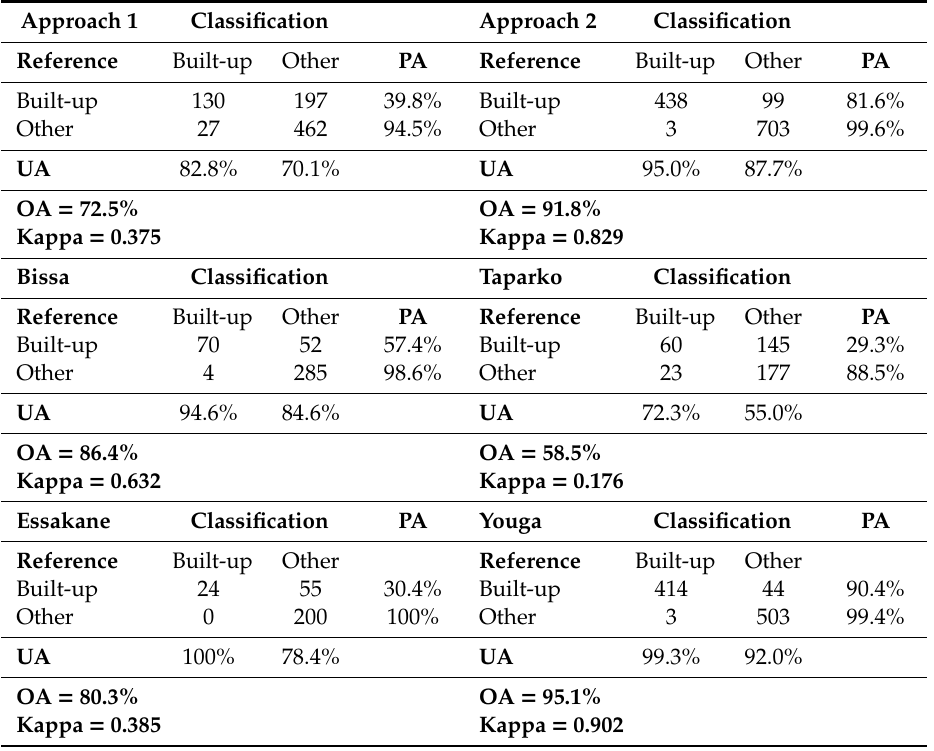
Table 2. Accuracy assessment by training data generation approach and study area. Approach 1 refers to obtaining training data within the whole scene. In approach 2 training data was only generated from the proximity of the study areas. Overall accuracy (OA), producer’s accuracy (PA), user’s accuracy (UA) and the Kappa coe ffi cient are